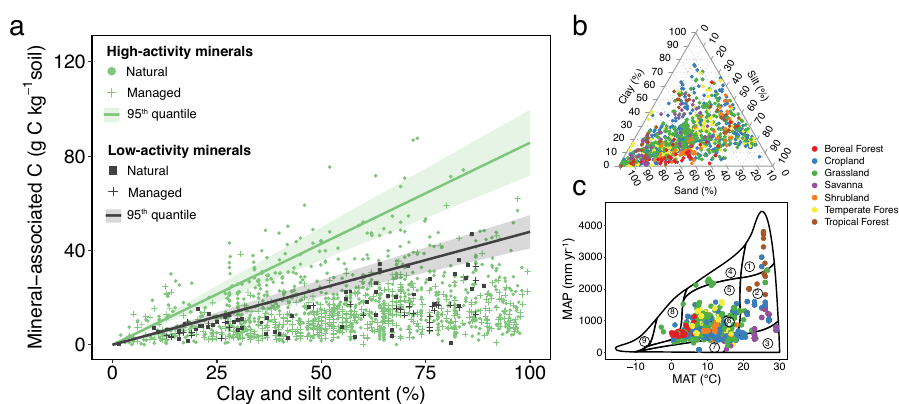
Fig. 1 Maximum mineral-associated carbon as a function of clay and silt content for high- and low-activity mineral soils estimated from a global observational synthesis. a Mineral-associated organic carbon (MOC; g C kg − 1 soil) as a function of clay and silt content (CS; %) across sites. The maximum slope ( fi t as the 95th quantile) for each soil type represents the intrinsic capacity of minerals to store carbon and depends on mineral composition. High-activity minerals (HM) include soils dominated by illite, smectite, vermiculite, and chlorite ( n = 1303) and low-activity minerals (LM) include soils dominated by kaolinite and gibbsite ( n = 93). Shading depicts 90% con fi dence intervals on the slope. Soils near the upper quantiles are closer to MOC saturation. Within HM and LM soils, fi lled markers and crosses denote natural and managed ecosystems, respectively. b , c Distribution of soil texture ( b ) and climate ( c ) across sites. Black polygons depict Whittaker ’ s biomes 119 according to mean annual temperature (MAT; °C) and mean annual precipitation (MAP; mm yr − 1 ) values, following: (1) tropical rainforest; (2) tropical seasonal rainforest/savanna; (3) subtropical desert; (4) temperate rainforest; (5) temperate seasonal forest; (6) woodland/shrubland; (7) temperate grassland/desert; (8) boreal forest; and (9)